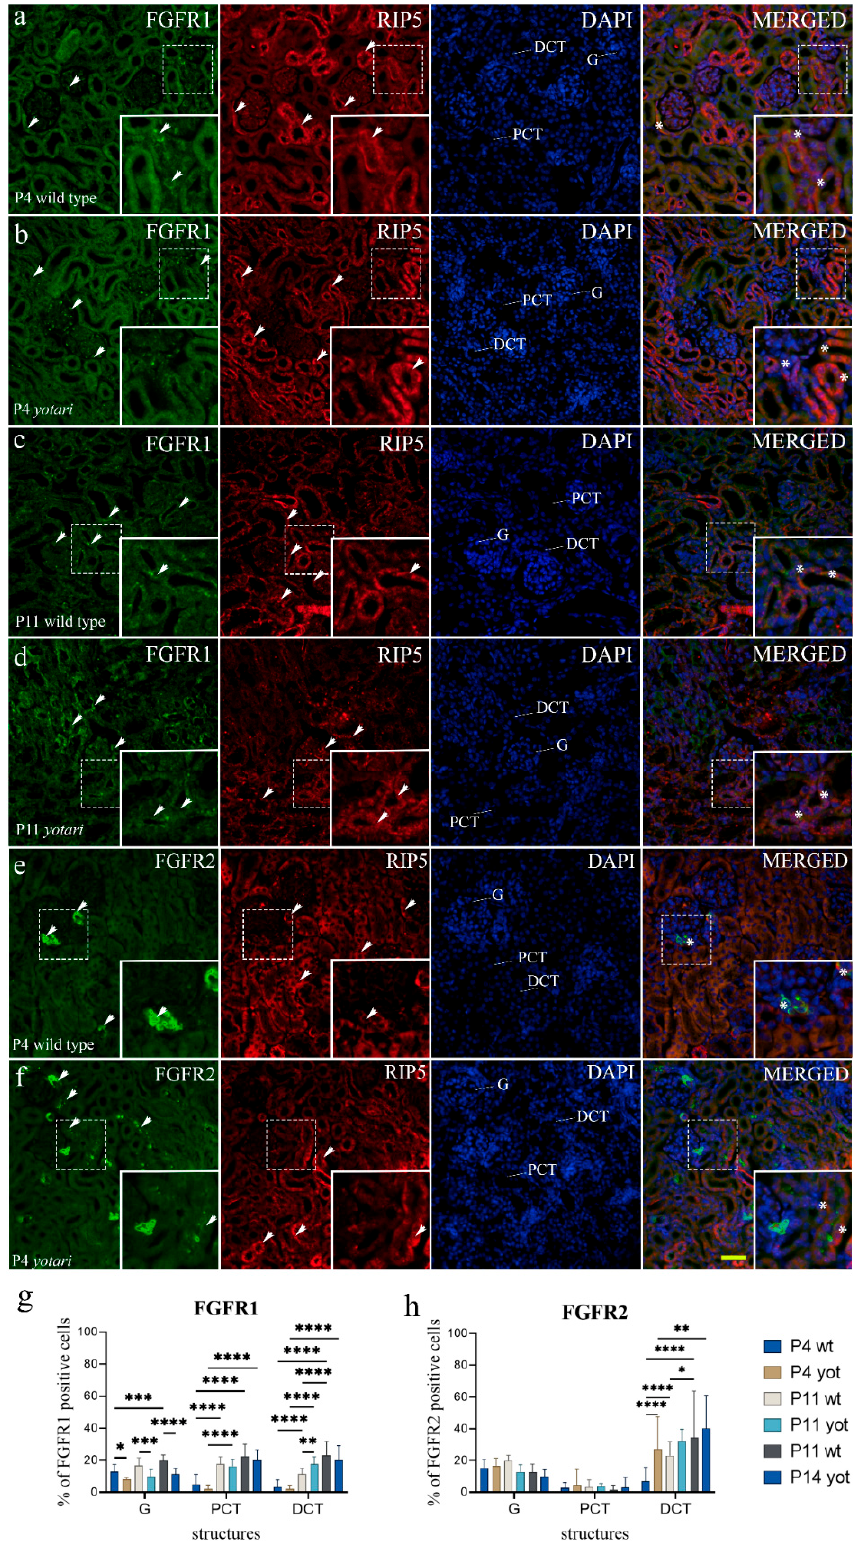
Figure 2. Double immunofluorescence staining of postnatal wild-type and yotari mouse kidneys with the FGFR1 ( a – d ), FGFR2 ( e , f ), and RIP5 markers ( a – f ). Arrows show the expression pattern of FGFR1, FGFR2, and RIP5 in glomeruli (G), proximal convoluted tubules (PCT), and distal convoluted tubules (DCT) indicated on 4 ′ ,6-diamidino-2-phenylindole (DAPI) image. Immunoexpression of FGFR1, RIP5, DAPI staining and merged FGFR1, RIP5, and DAPI at 4 days (P4) and 11 days (P11) in wild type ( a , c ) and yotari ( b , d ). Wild-type and yotari mice at postnatal days